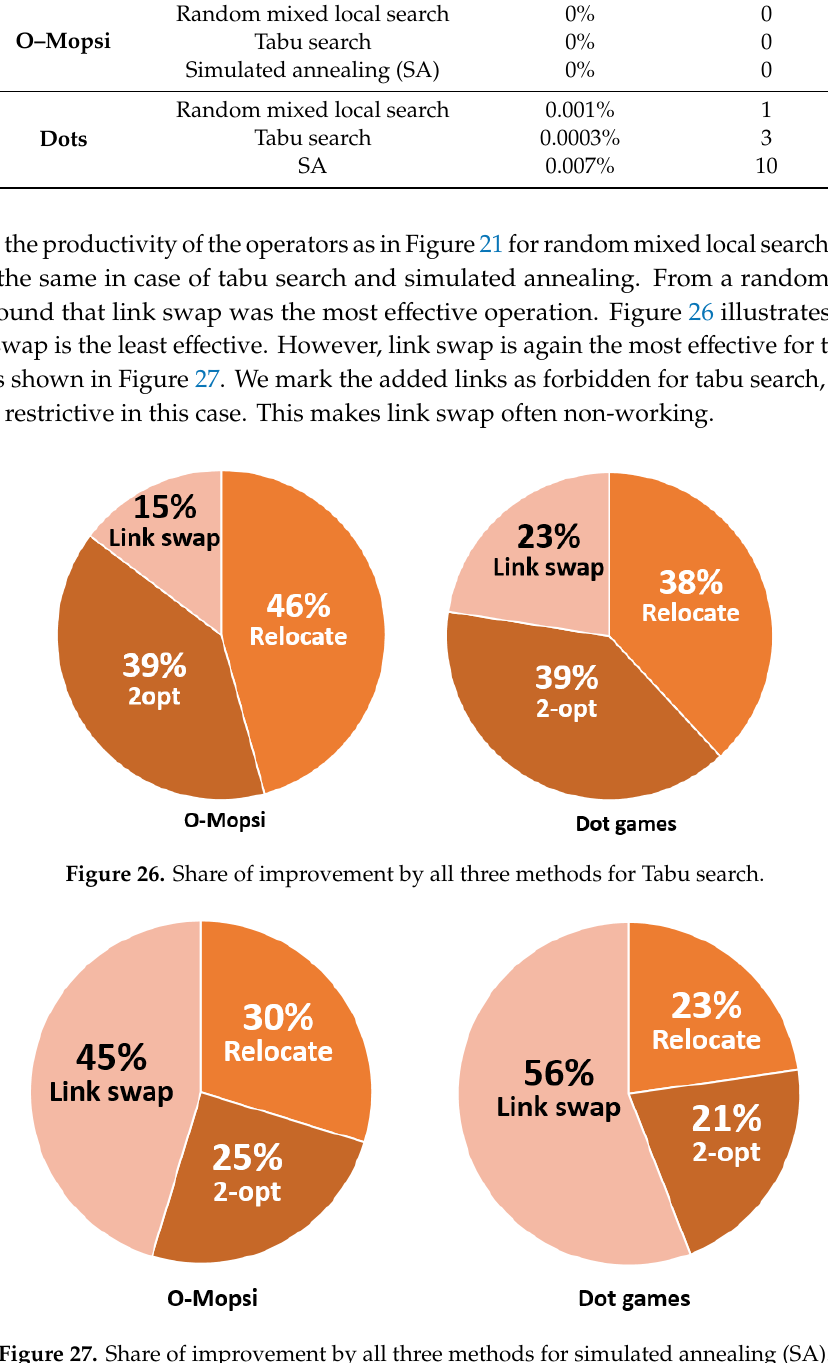
Figure 27. Share of improvement by all three methods for simulated annealing